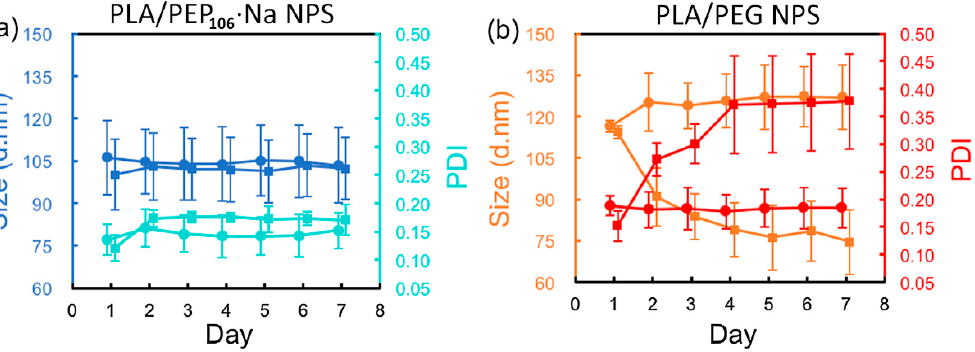
Figure 6. Particle size and polydispersity index (PDI) of PLA/PEP 106 ·Na NPs ( a ) and PLA/PEG NPs ( b ) suspended in water (•) and PBS ( ▪ ) during days 1–7. Reprinted with permission from [80]. Copyright (2017) Elsevier B. V.